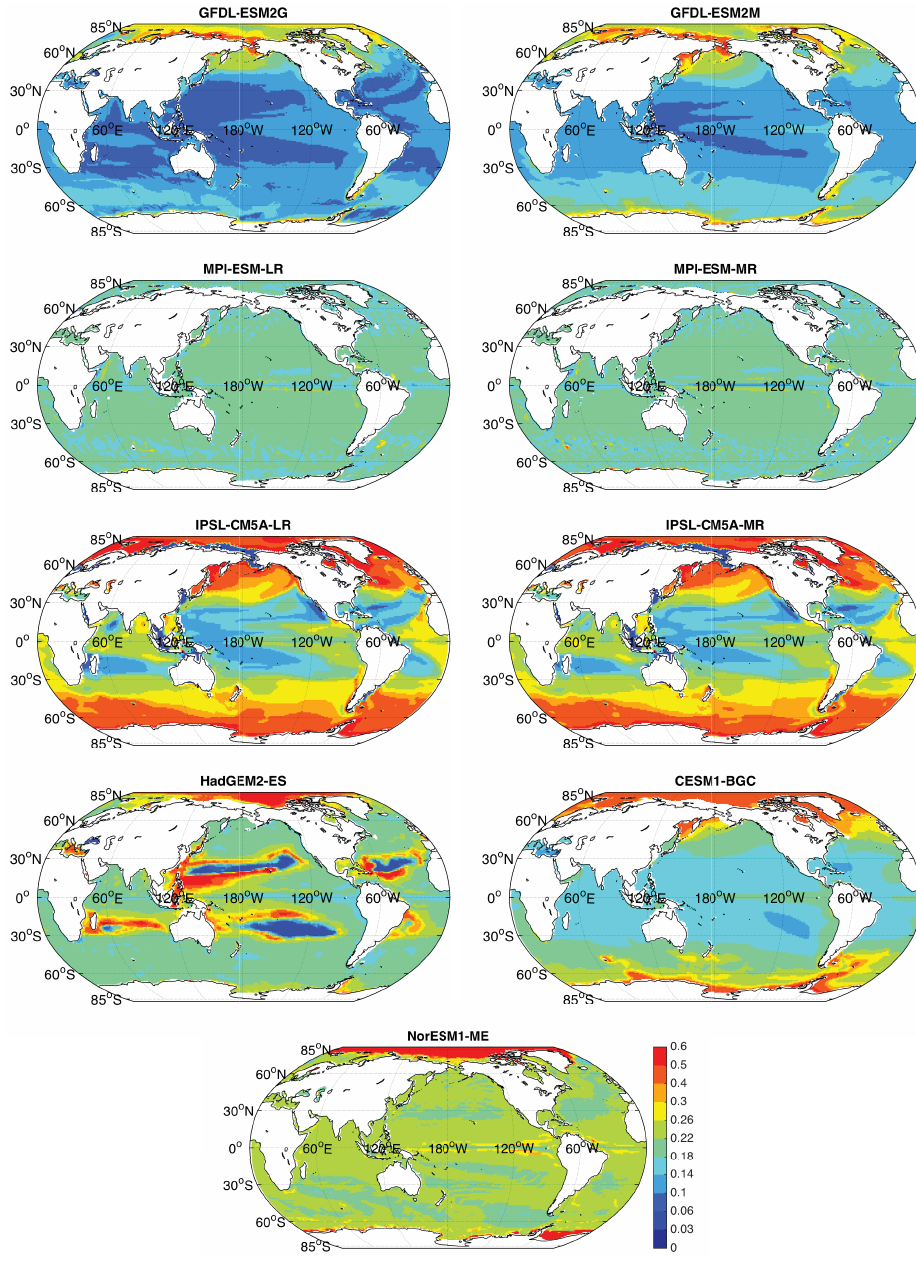
Figure 10. The mean pe-ratio for the 1990s is shown for each